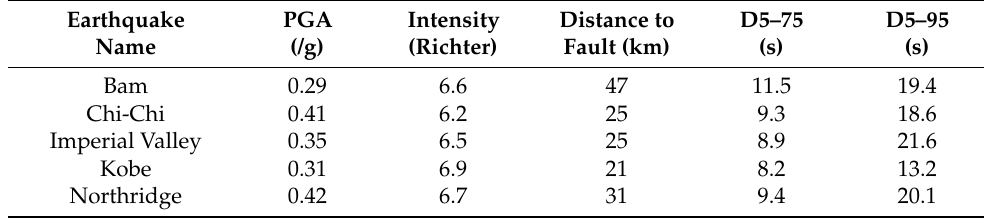
Table 2. Characteristics of earthquake records used for numerical